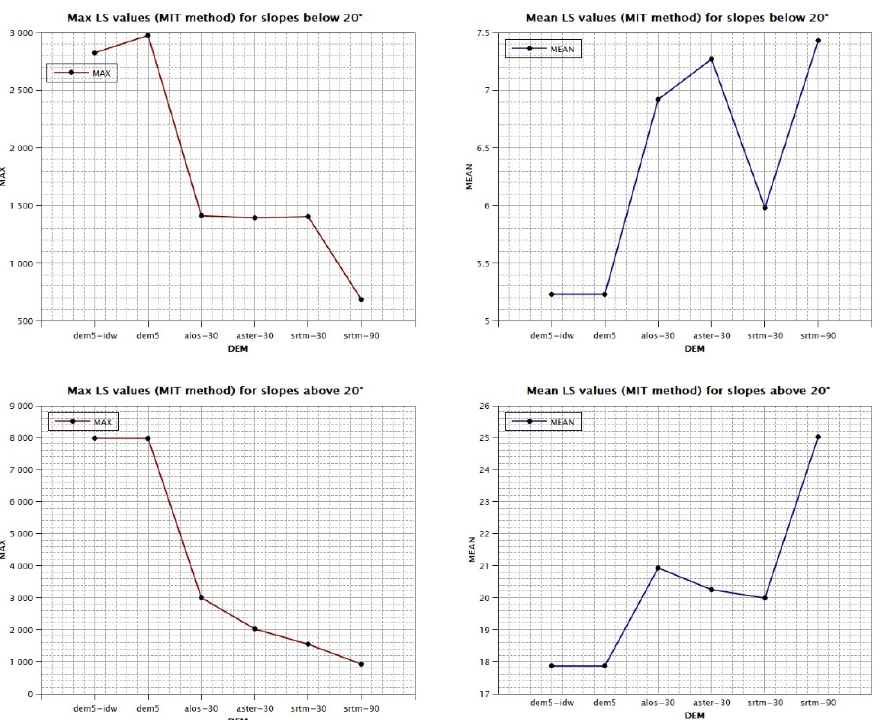
Figure 10. Maximum and mean values of LS factor for slopes below and above 20° (MIT method).